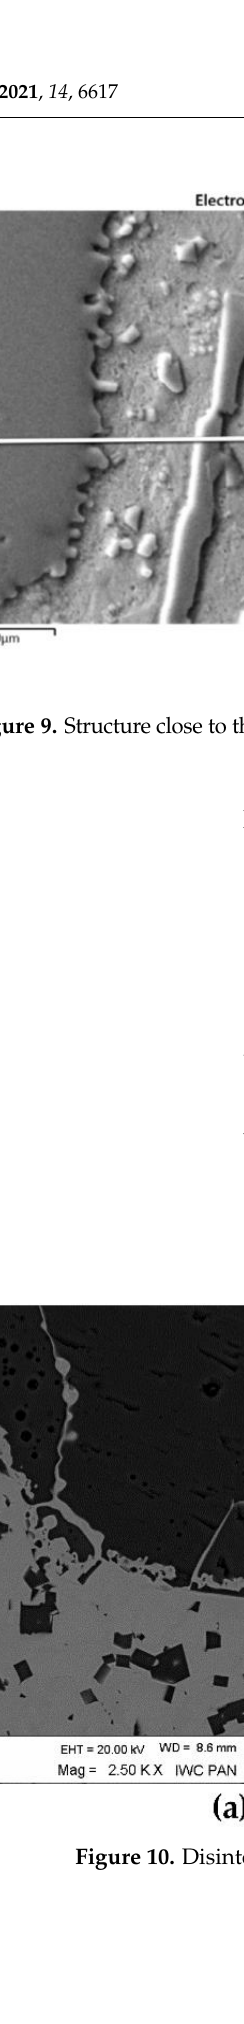
Figure 8. NiBSi-ZrC layer: SEM micrograph with points of the quantitative analysis marked ( a ), linear propagation of components along the marked line ( b ) and EDS maps of C ( c ), Zr ( d ), Ni ( e ), and Fe ( f ) distribution.